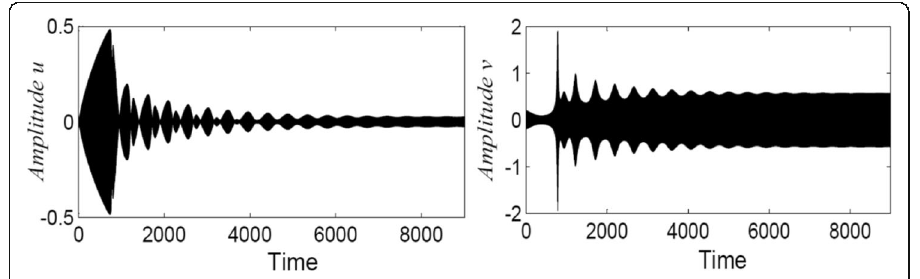
Fig. 2 System behavior with a controller at resonance Ω 1 ≅ ω 1 , Ω 2 ≅ 2 ω 1 , ω 1 ≅ 3 ω 2 for initial conditions u ð 0 Þ ¼ 0 : 02 ; ˙ u ð 0 Þ ¼ 0 ; ν ð 0 Þ ¼ 0 : 2 ; ˙ ν ð 0 Þ ¼ 0 : μ 1 ¼ 0 : 001 ; μ 2 ¼ 0 : 00098 ; f 1 ¼ 0 : 01 ; f 2 ¼ 0 : 05 ; α 1